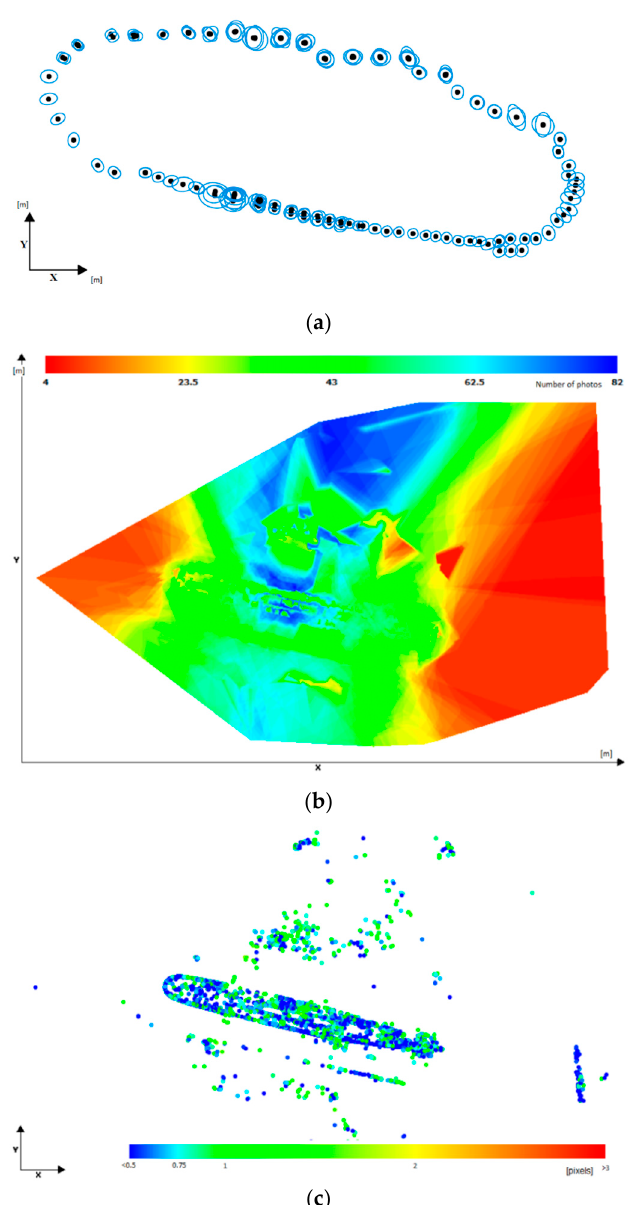
Figure 4. ( a ) Camera position uncertainties: top view (XY plane) of computed photo positions (black dots). Blue ellipses indicate the position uncertainty, scaled for readability, ( b ) number of photos seeing the scene (XY plane), ( c ) reprojection Errors per Tie Point: top view (XY plane) displays of all tie points, with colors representing the reprojection error in pixels.